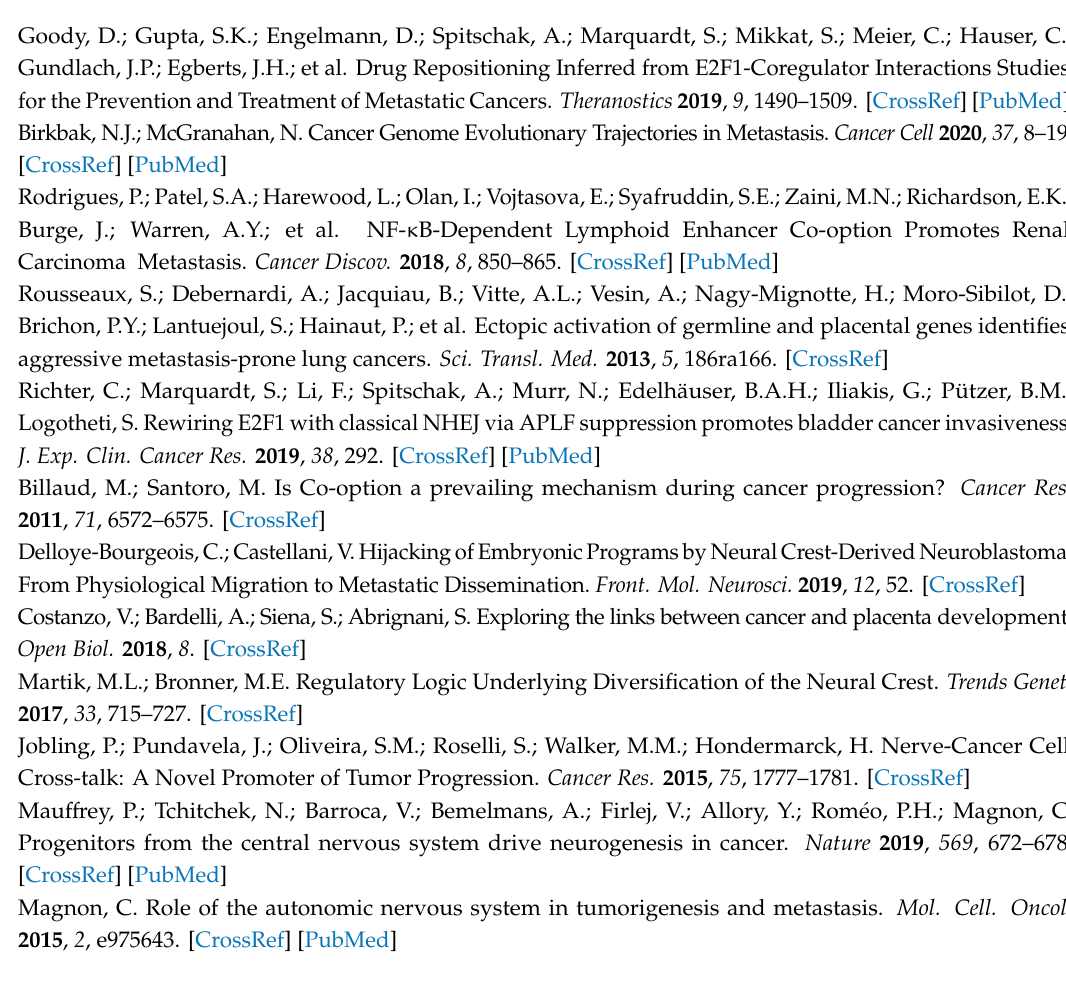
Tables S1–S9. Table S1: Mouse gene knockouts which present abnormalities in neuronal development. Table S2: Mouse gene knockouts which present abnormalities in neurological / behavioral function. Table S3: 100 lists of random coding genes as controls for neu.dev (upper) and behavioral (lower) genes. Table S4: CCLE classification, cancer cell lines classified into less and highly invasive based on the EMT markers expression profiles. Table S5: Nervous system-related genes and their e ff ect on patient survival prognosis in PanCancer based on Cox regression analysis. Table S6: Nervous system-related genes and their e ff ect on patient survival prognosis in di ff erent cancer types of TCGA based on Cox regression analysis. Table S7: Poor prognostic factors with brain or peripheral nervous system-specific expression profiles. Table S8: Nervous system-related genes that predict poor prognosis across 10–17 cancer types, and their responsiveness to prometastatic p73 ∆ Ex2 / 3 β . The p73 ∆ Ex2 / 3 β -responsive predictors are highlighted in red. Table S9: Primers used in qPCR. Table S10: Samples per gene expression dataset analyzed in the present study. The samples indicated by red were compared to those shown in